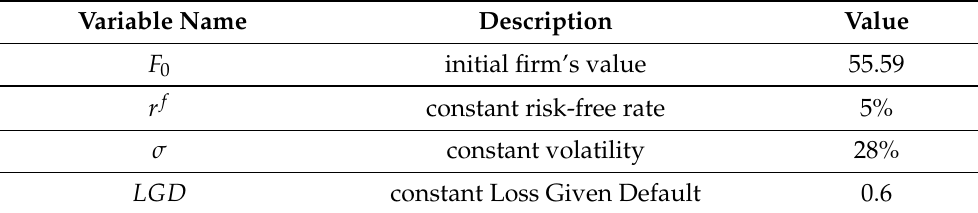
Table 1. Initial Information about the market.